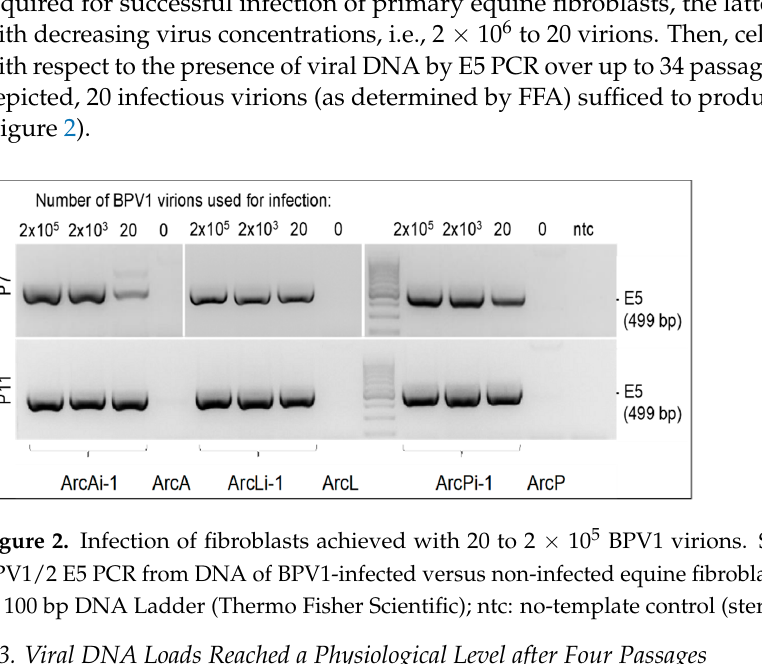
Figure 1. BPV1- and 2-infected fibroblasts lose contact inhibition and form aggregates. ( A ): non-